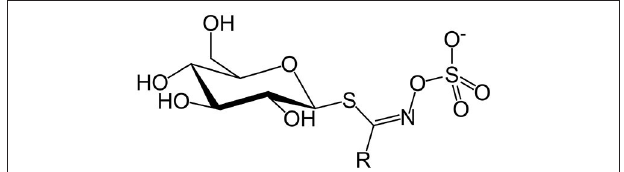
FIGURE 1 | Glucosinolate structure (the side group R